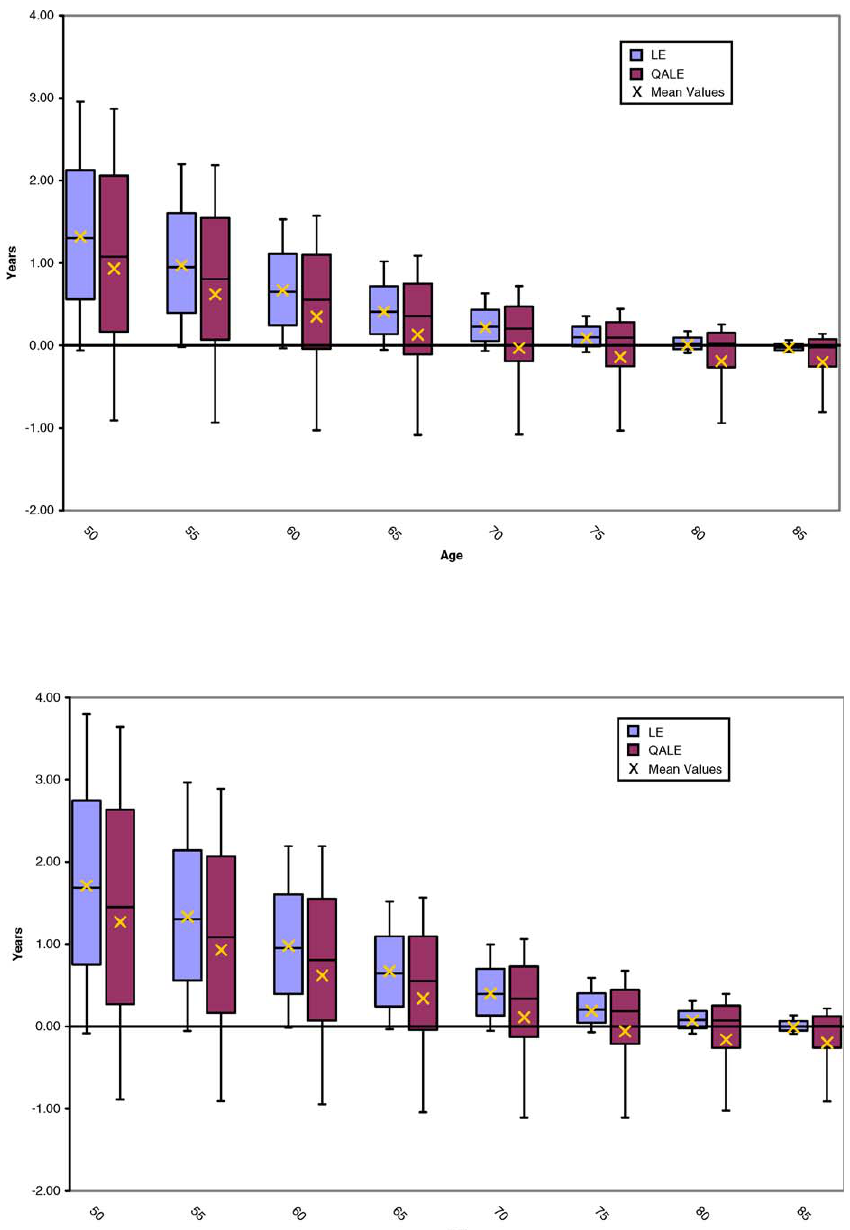
Figure 2. Box Plots of Incremental Gain in LE and QALE with Immediate Cystectomy by Age for Male (Upper Plot) and Female Patients (Lower Plot) The region in the shaded boxes of both plots represents the interquartile range. The solid line within boxes is the median incremental gain, whereas the mean value is presented as an ‘‘ 3 ’’ . Upper and lower whiskers indicate the 10th and 90th percentiles,